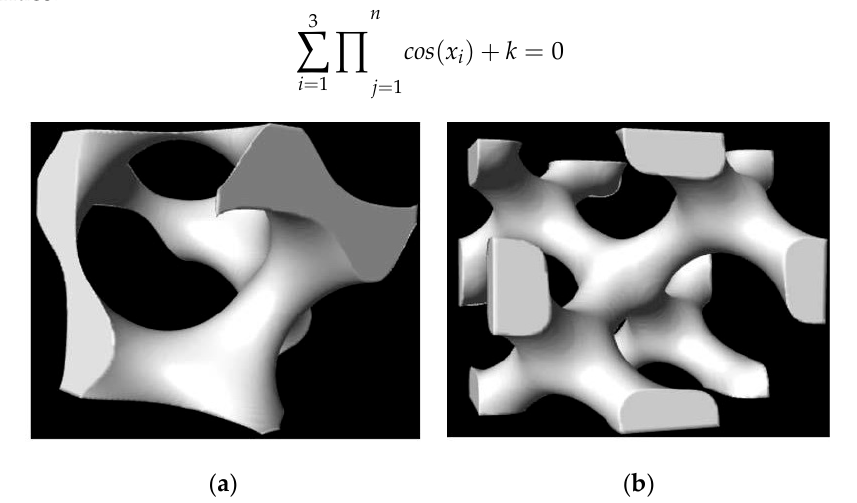
Figure 15. Two types of unit cells [175]: ( a ) Schoen Gyroid; ( b ) Schwartz Diamond.